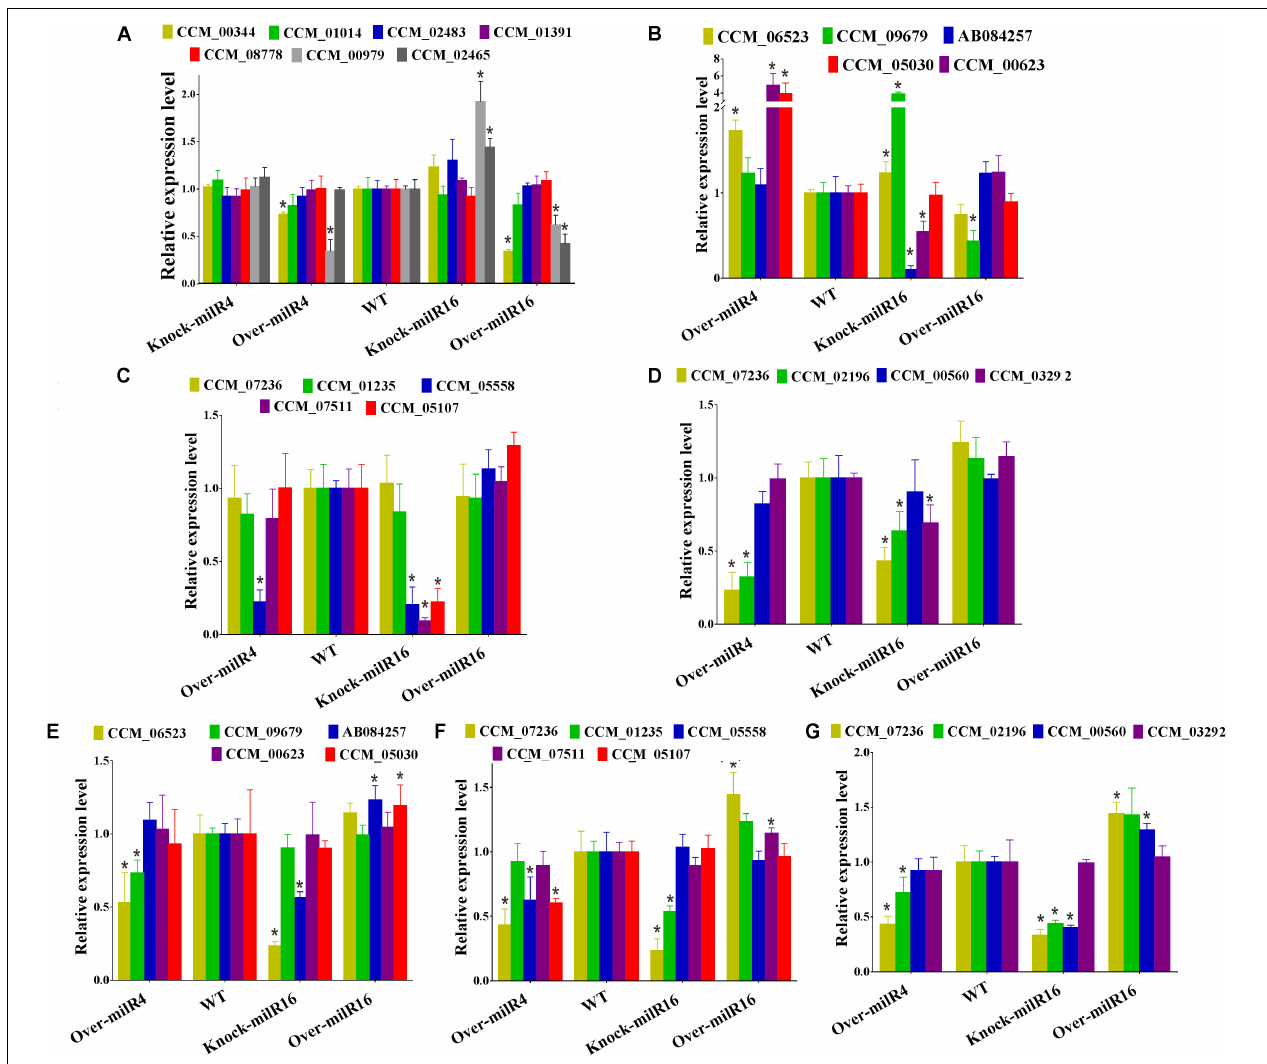
FIGURE 5 | Analysis of the relative expression levels of genes involved in asexual or sexual development of different strains. (A) Expression levels of seven asexual development-associated genes. Expression levels of five genes for mating process (B) , five genes for mating signaling (C) and four genes for fruiting body development (D) from 21 days old cultured strains. Expression levels of five genes for mating process (E) , five genes for mating signaling (F) , and four genes for fruiting body development (G) from 52 days old cultures strains. All data are expressed as means ± SE of the values from six independent experiments. The asterisk “ ∗ ” represents a significant difference level of P <